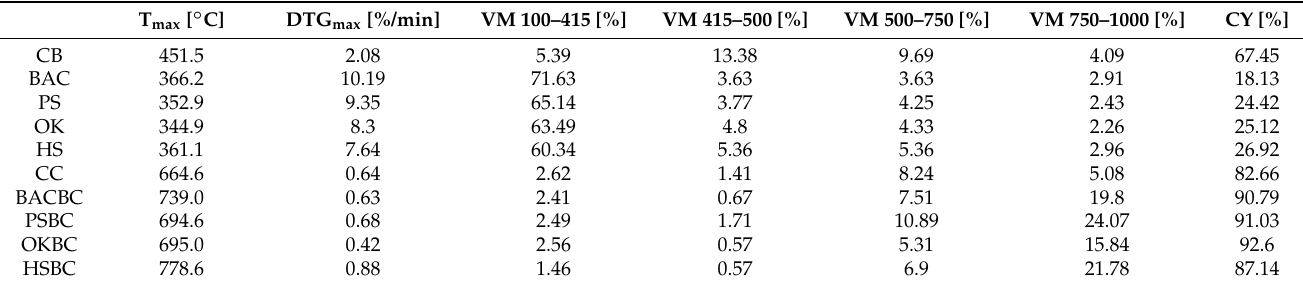
Table 2. Results of TG analysis of investigated raw